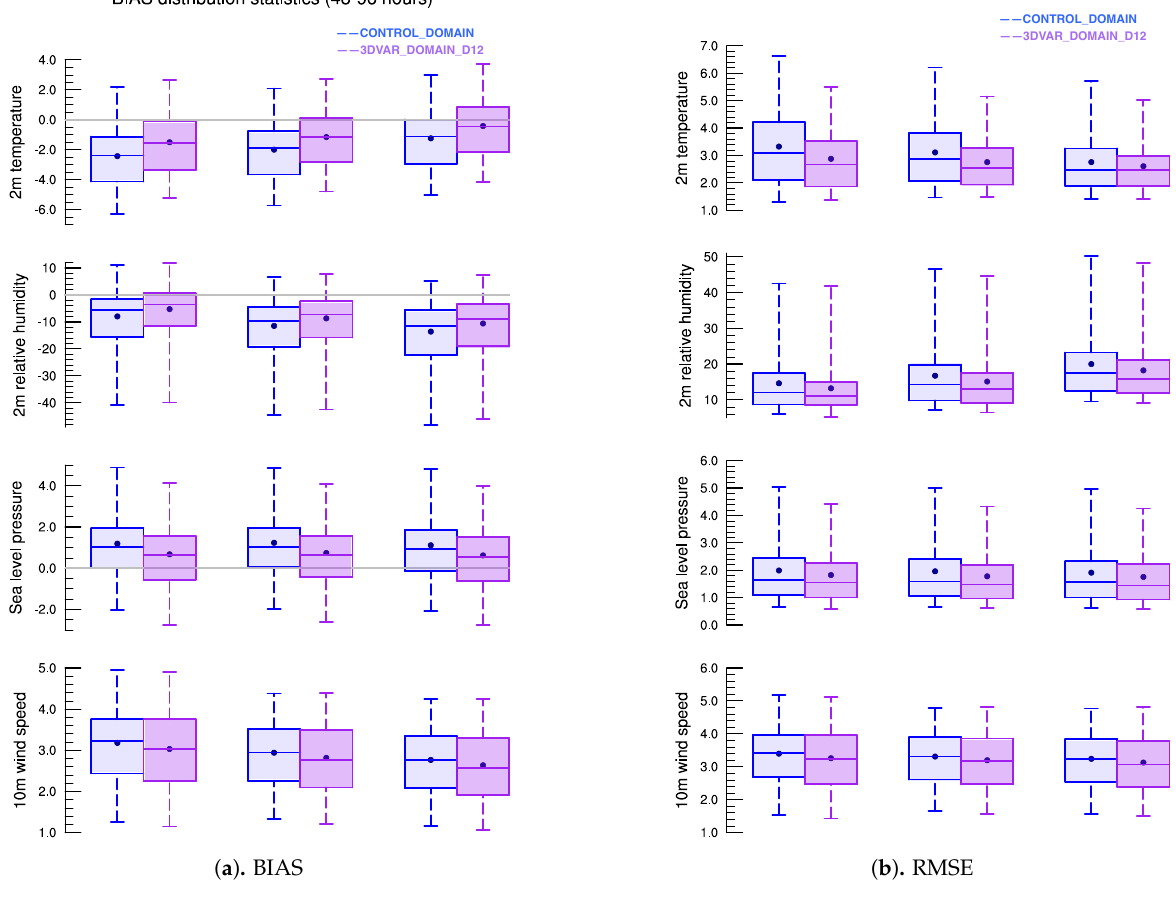
Figure 6. The distribution statistics of BIAS time and RMSE time for variables T2, RH2, SLP, and 10 m wind for all the time period sensitivity experiment cases [CONTROL_DOMAIN(left), 3DVAR_DOMAIN(right)] between the 48 and 96 h time window, evaluated at the 27 km ( left ), 9 km ( center ) and 3 km ( right ) resolution domains. The blue dots refer to the mean.